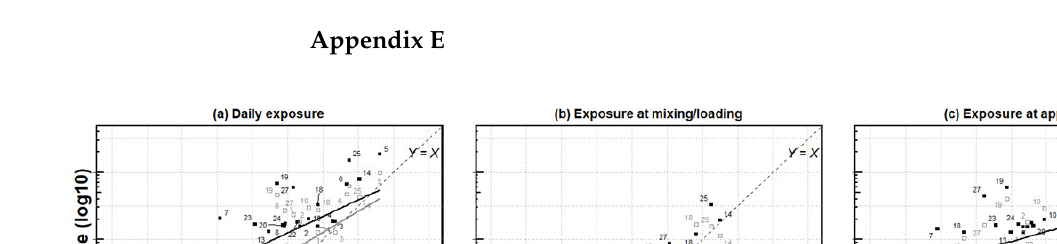
Figure A5. Linear regression of daily exposure considering head and removing head.